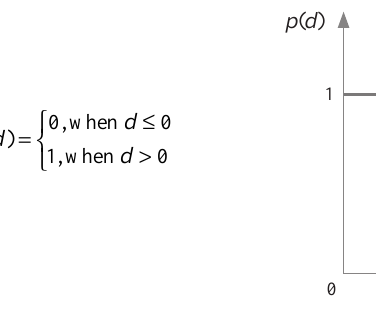
Fig. 1. Usual preference function and its graph